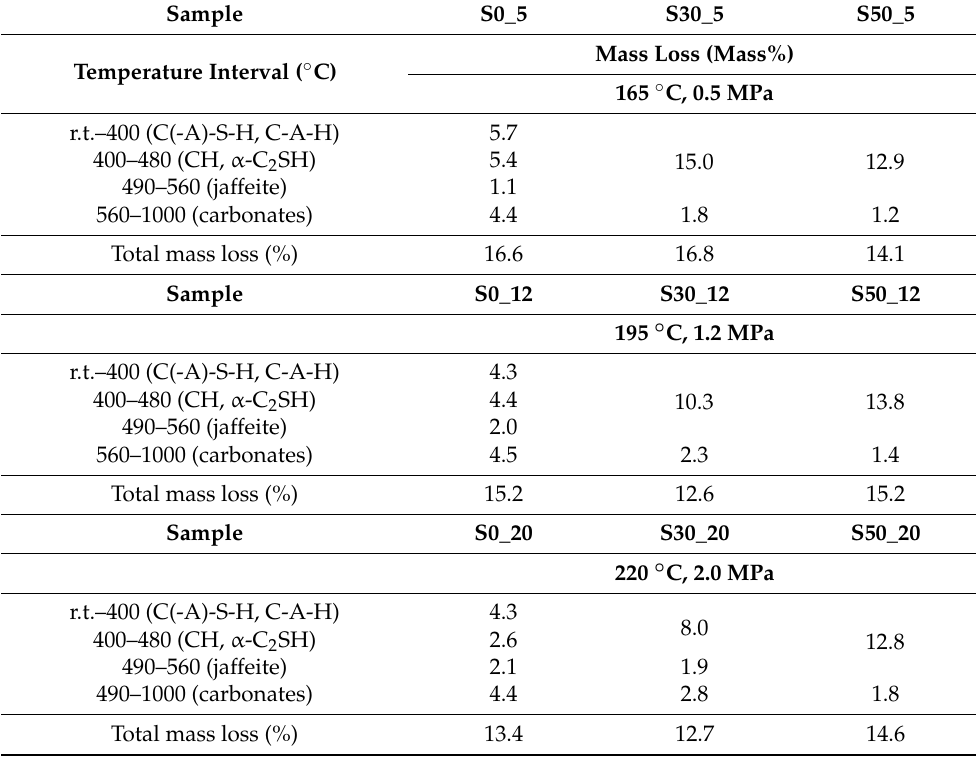
Figure 8. Comparison of DTG curves of samples with and without SF additions submitted to the modest and the most severe hydrothermal conditions for 7 days. Table 4. Total mass loss, and mass loss of prepared samples in different temperature intervals corresponding to particular hydration products. Displayed temperature intervals are only approximate. Corresponding mass losses were determined according to the particular DTG curves.